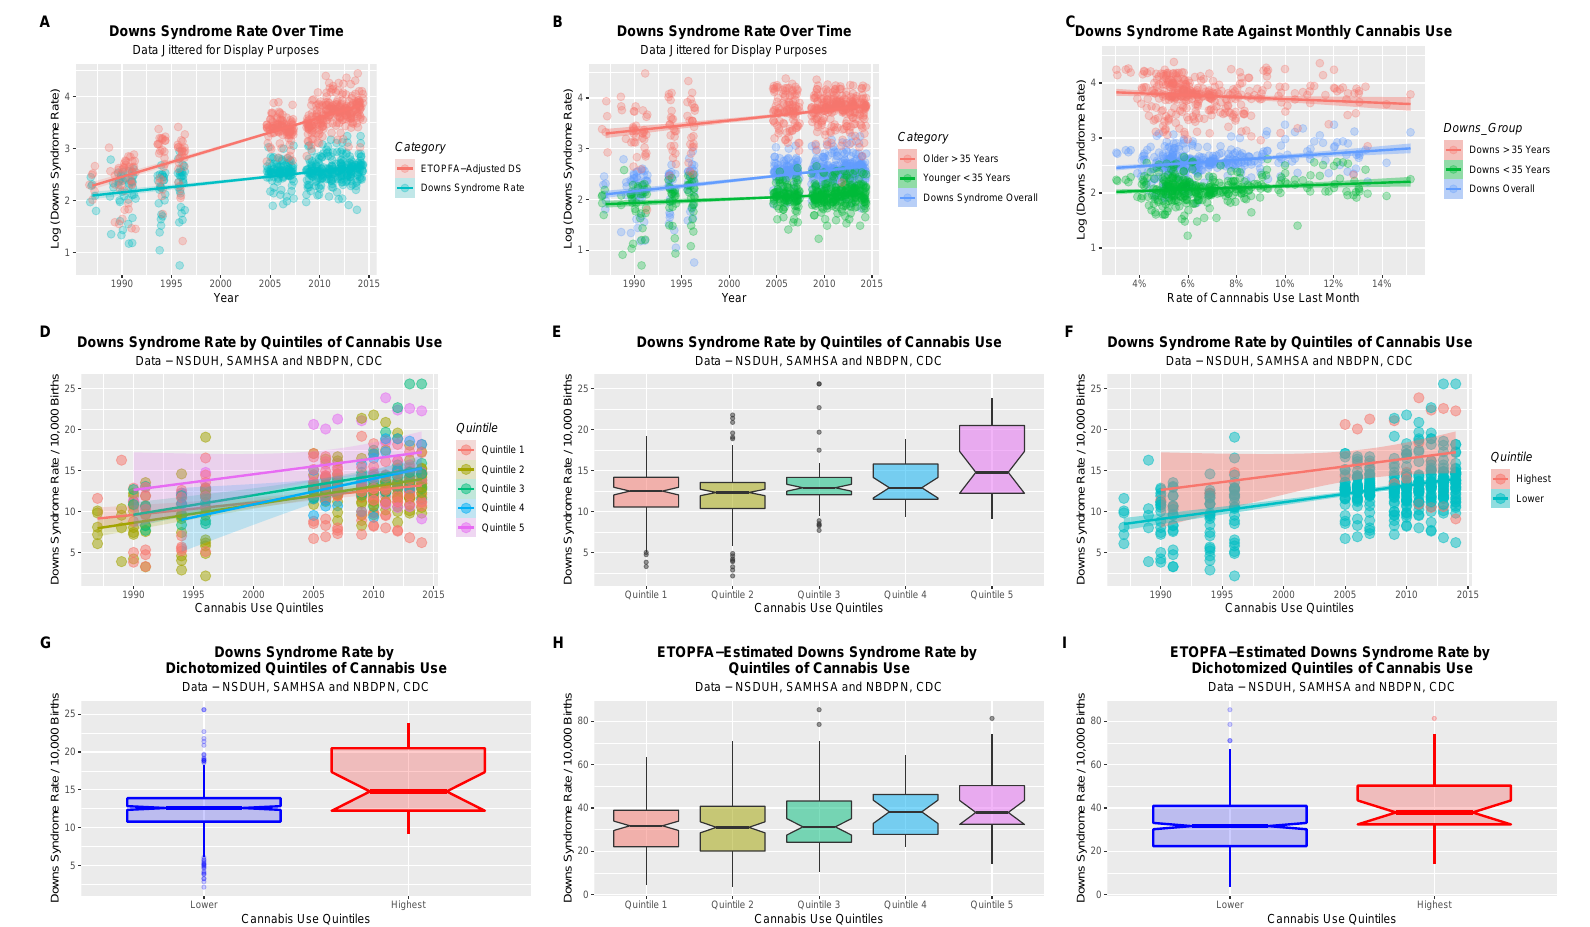
Figure 2. Down Syndrome Univariate analysis. ( A ) DS rate over time for both raw rates and ETOPFA-corrected estimates. ( B ) DS rates over time by maternal age group. ( C ) DS rates as a function of cannabis use. ( D ) DS rates over time by cannabis use quintiles. ( E ) Boxplot of DS rates by cannabis use quintiles. ( F ) DS Rates over time by dichotomized quintiles. Quintiles 1–4 have been collapsed into the “Lower category”. The highest quintile is Quintile 5. ( G ) Boxplot of dichotomized cannabis use quintiles. ( H ) Boxplot of cannabis use quintiles of ETOPFA-corrected DS estimates. ( I ) Boxplot of dichotomized cannabis use quintiles for ETOPFA-corrected DS Rates. Note that non-overlapping notches signifies statistical